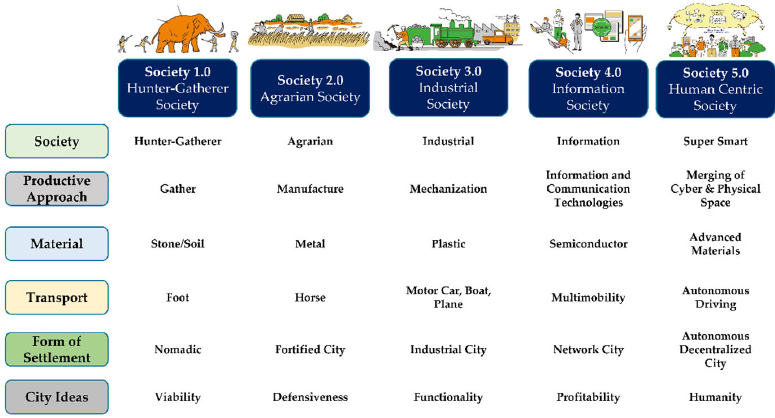
Figure 4. Societal evolutions categorized in key aspects.